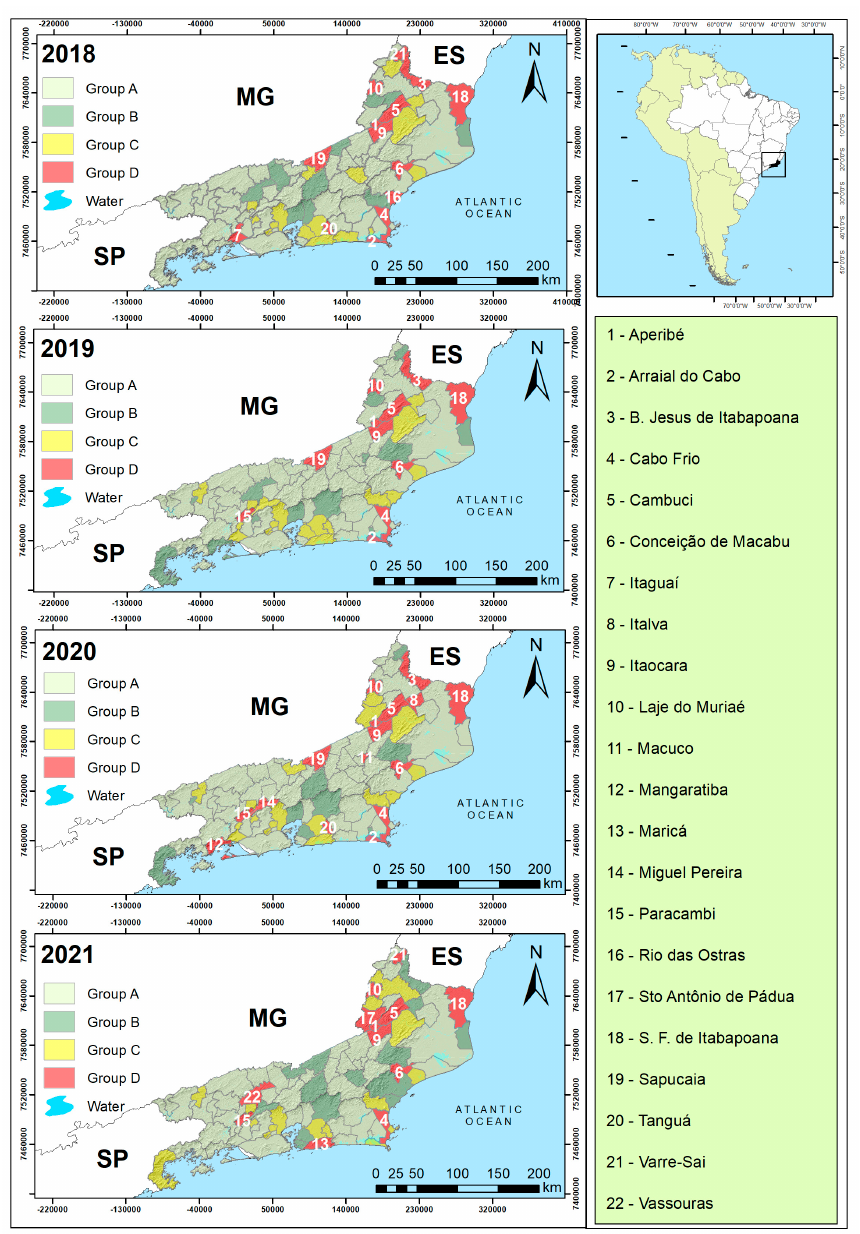
Figure 1. Schemes follow the same formatting. Map of the Rio de Janeiro State. Quality ranking (light green, Group A; dark green, Group B; yellow, Group C). Cities in Group D (red) are without basic monitoring samples for the periods 2018 (14), 2019 (12), 2020 (16), and 2021 (12). The label caption is on the right side. Seven cities did not have any data (Aperib é , S. Francisco de Itabapoana, Cabo Frio, Cambuci, Conceiç ã o de Macab ú , Itaocara, and Laje do Muria é